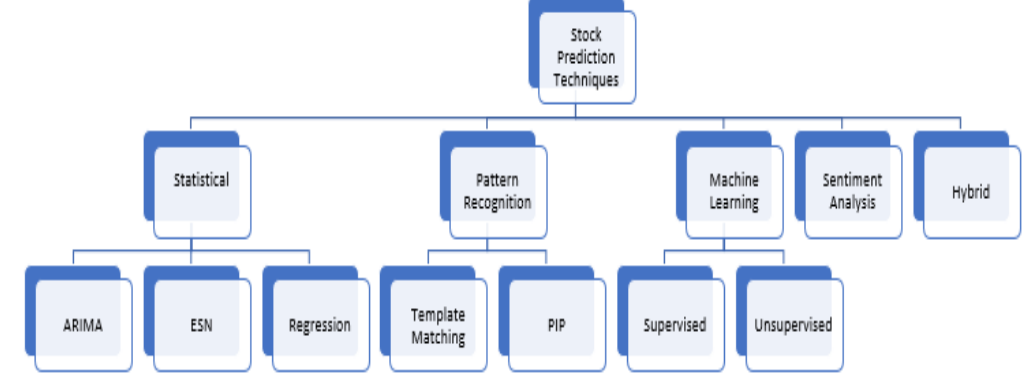
Figure 1. Taxonomy of stock prediction techniques.